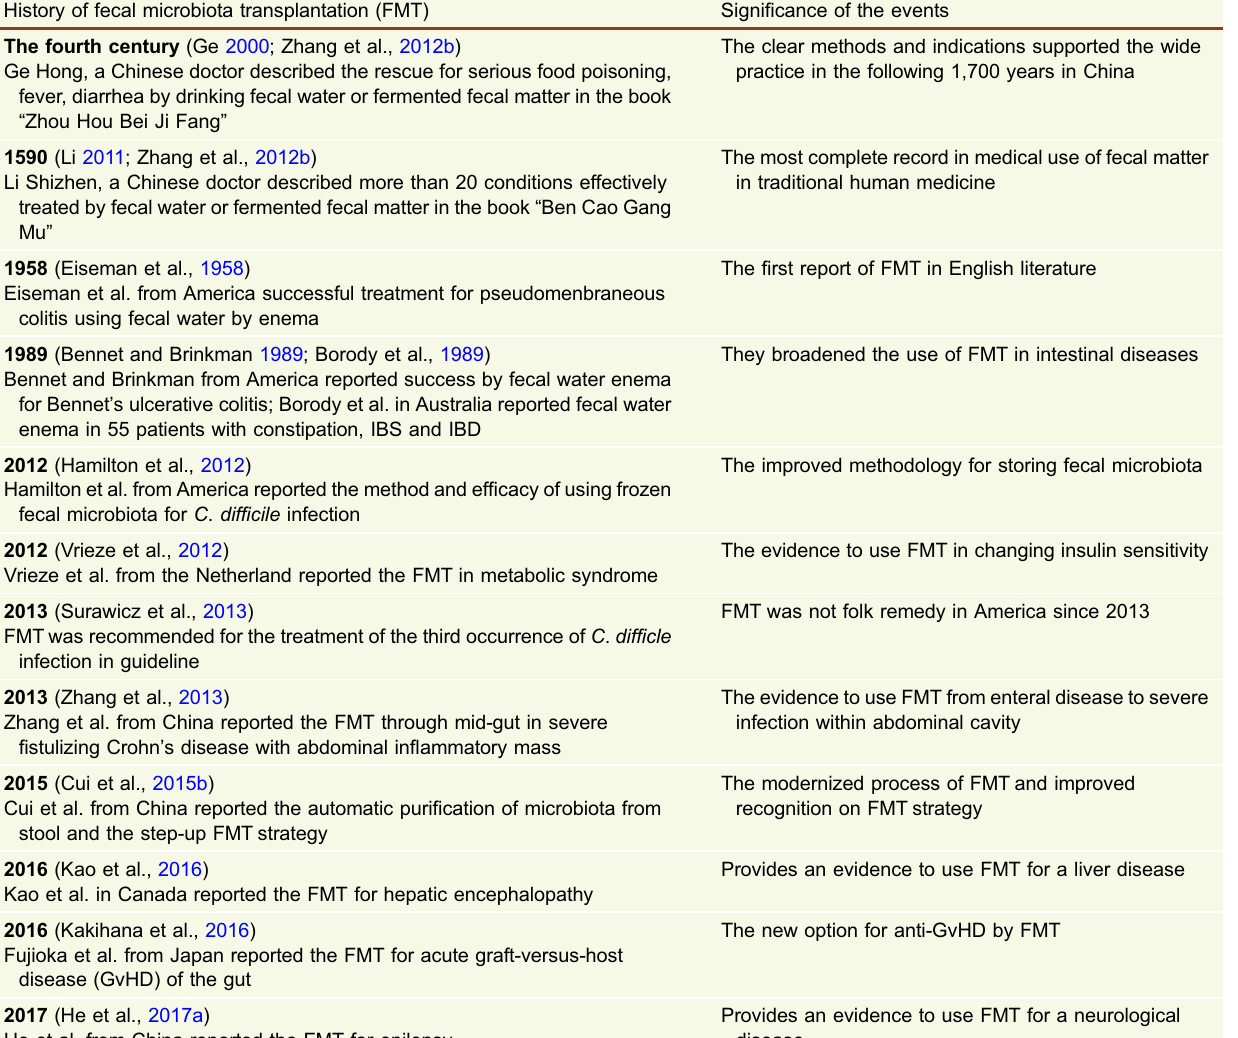
Table 1. The important events using fecal microbiota transplantation in history History of fecal microbiota transplantation (FMT) Signi fi cance of the